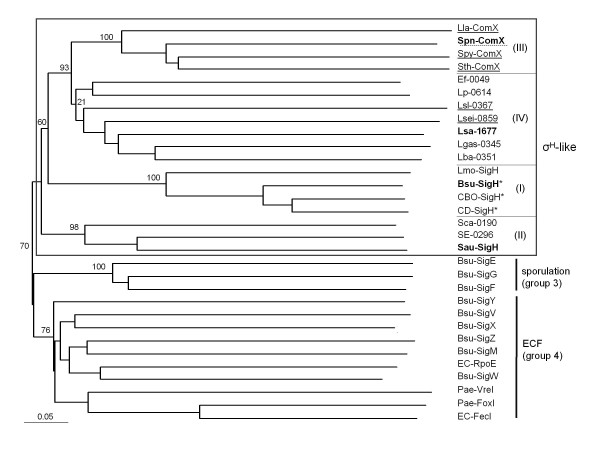
Clustering of selected σ70-superfamily of sigma factors. The unrooted tree resulted from a multiple alignment over the whole aa sequence length of σH-like factors and known sigma factors from group 3 (sporulation factors of B. subtilis) and group 4 (ECF factors from B. subtilis and Gram-negative bacteria). The multiple alignment was generated using clustalX [19], by introducing first the shortest sequences to ensure a correct alignment of the conserved regions. The tree was drawn with NJplot http://pbil.univ-lyon1.fr/software/njplot.html. Bootstrap values (number of seeds: 1000, number of trials: 100) are indicated for the upper branches. Evolutionary distance is represented by branch length (scale at the bottom). Groups of σH-like factors were numbered as previously reported [12] and a fourth group (IV) was added by our analysis. Bsu, Bacillus subtilis 168; EC, E. coli K-12 substr. MG1655; Pae, Pseudomonas aeruginosa PAO1; Ef, Enteroccocus faecalis V583; Lla, Lactococcus lactis Il1403; Lmo, Listeria monocytogenes EGD-e; Genus Clostridium: CBO, C. botulinum A ATCC3502; CP, C. difficile 630. Genus Lactobacillus: Lba, L. acidophilus NCFM; Lsei, L. casei ATCC334; Lgas, L. gasseri ATCC 33323; Lp, L. plantarum WCFS1; Lsa, L. sakei 23 K, Lsl, L. salivarius UCC118; Lac, L. acidophilus NCFM. Genus Staphylococcus: Sau, S. aureus N315; Sca, S. carnosus TM300; SE, S. epidermidis ATCC 12228. Genus Streptococcus: Spn, S. pneumoniae R6; Spy, S. pyogenes ATCC 10782; Sth, S. thermophilus LMD-9. Names of gene products or locus tags are indicated. σH-like sigma factors which belong to sporulating bacteria are indicated with an asterisk; those encoded by a gene not located at a similar locus to sigHBsu are underlined (dashed line for the particular case of S. pneumoniae, see Figure 1). The best studied σH-like sigma factor for each group is in bold type.